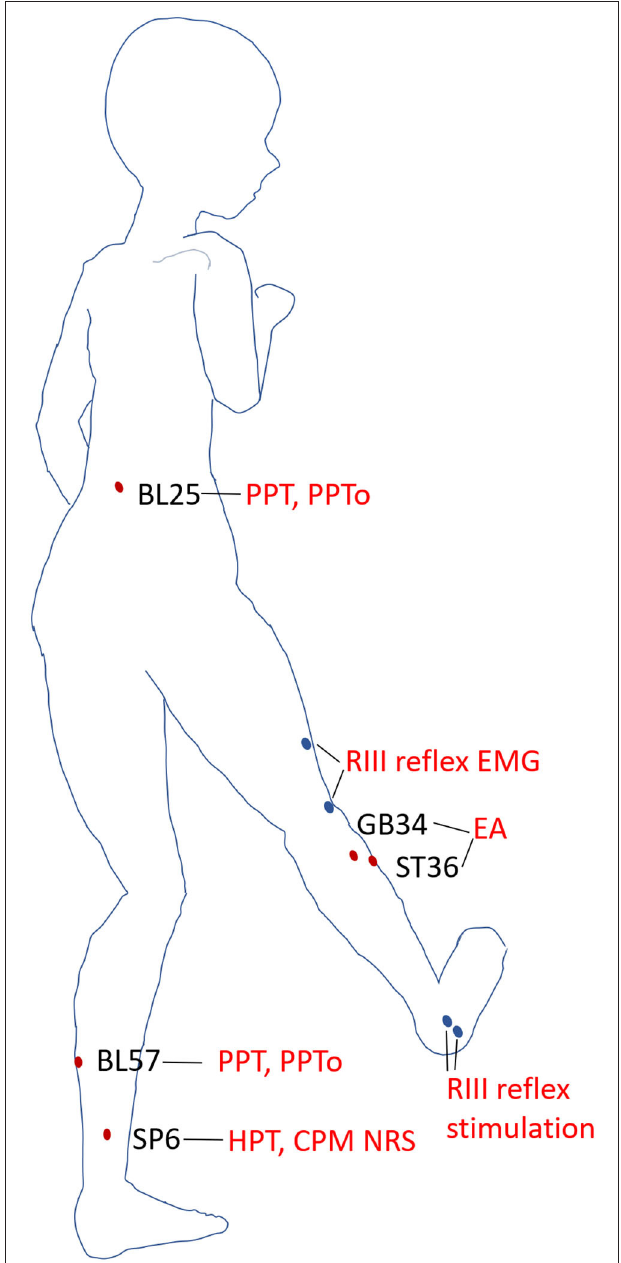
FIGURE 2 | Acupoints and areas of QSTs. Schematic diagram of the acupoints and areas tested in static and dynamic QSTs. Electroacupuncture (EA) was performed on ST36 and GB34. PPT and PPTo were examined at BL25 and BL57 in the prone position. HPT and NRS scores of heat stimulus were measured at SP6 when the subjects reclined relaxedly. The areas of RIII reflex stimulation and recording were blue dots in the diagram.